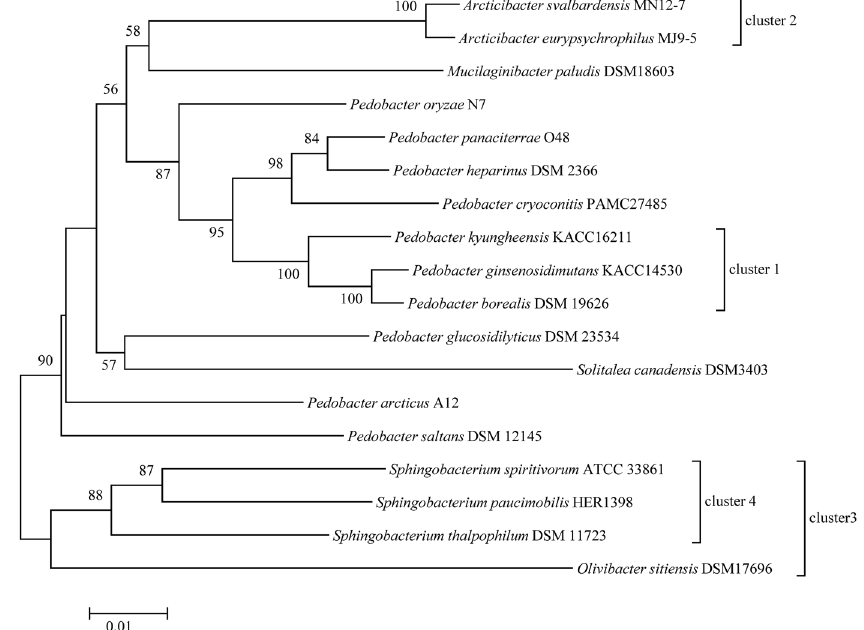
Figure 3. Phylogenetic relationships of the 18 strains analyzed, all 16S rRNA genes were extracted from each genome. Bar, 0.01 accumulated changes per nucleotide.